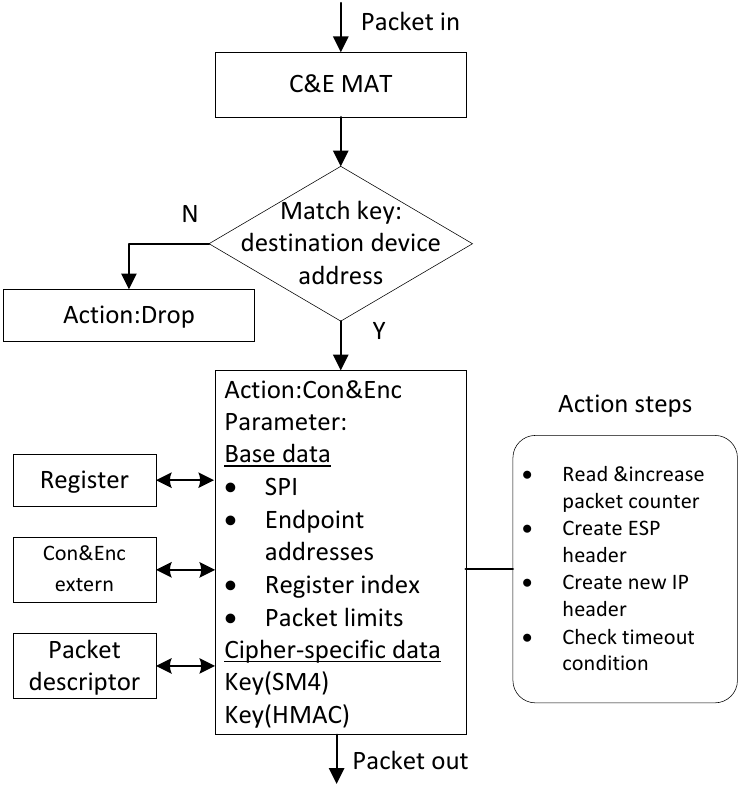
Figure 5. The C&E